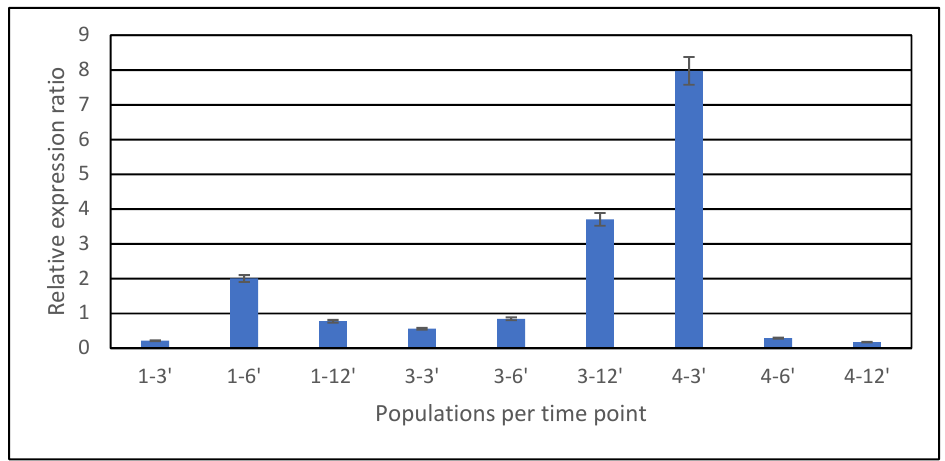
Figure 6. Relative expression ratio of the LpironinhibitedABC gene for the populations 1, 3 and 4 in glyphosate-applied leaves (3, 6 and 12 h after glyphosate application). The mRNA accumulation of the LpM10 transporter gene increased rapidly in population 4 at 3 h after treatment. For this ABC transporter gene, populations 1 and 3 showed a small increase in relative transcript expression (two-fold change) at 3 and 6 h after treatment, respectively (Figure 7).